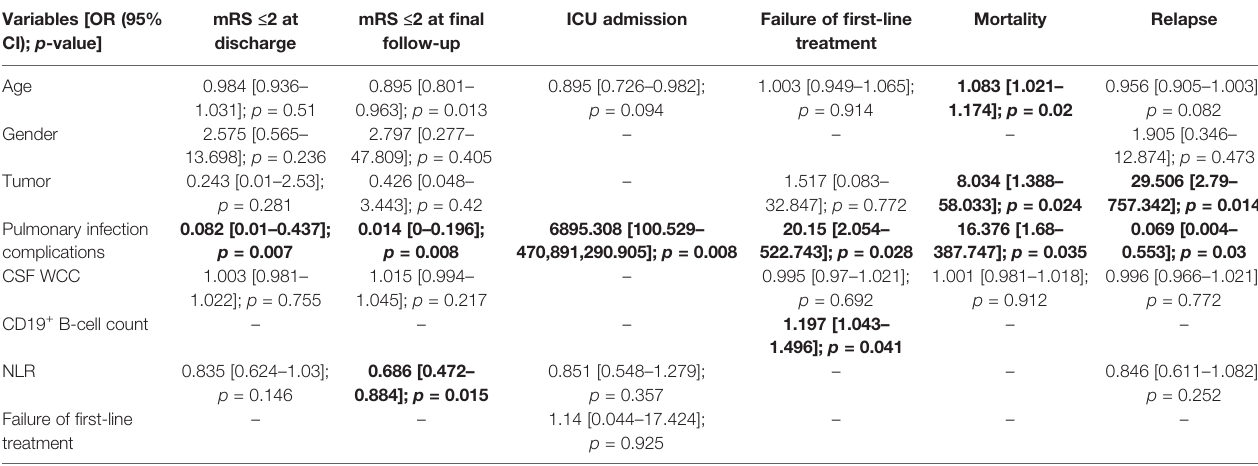
TABLE 4 | Multivariable logistic regression analysis for all severe AE patients.